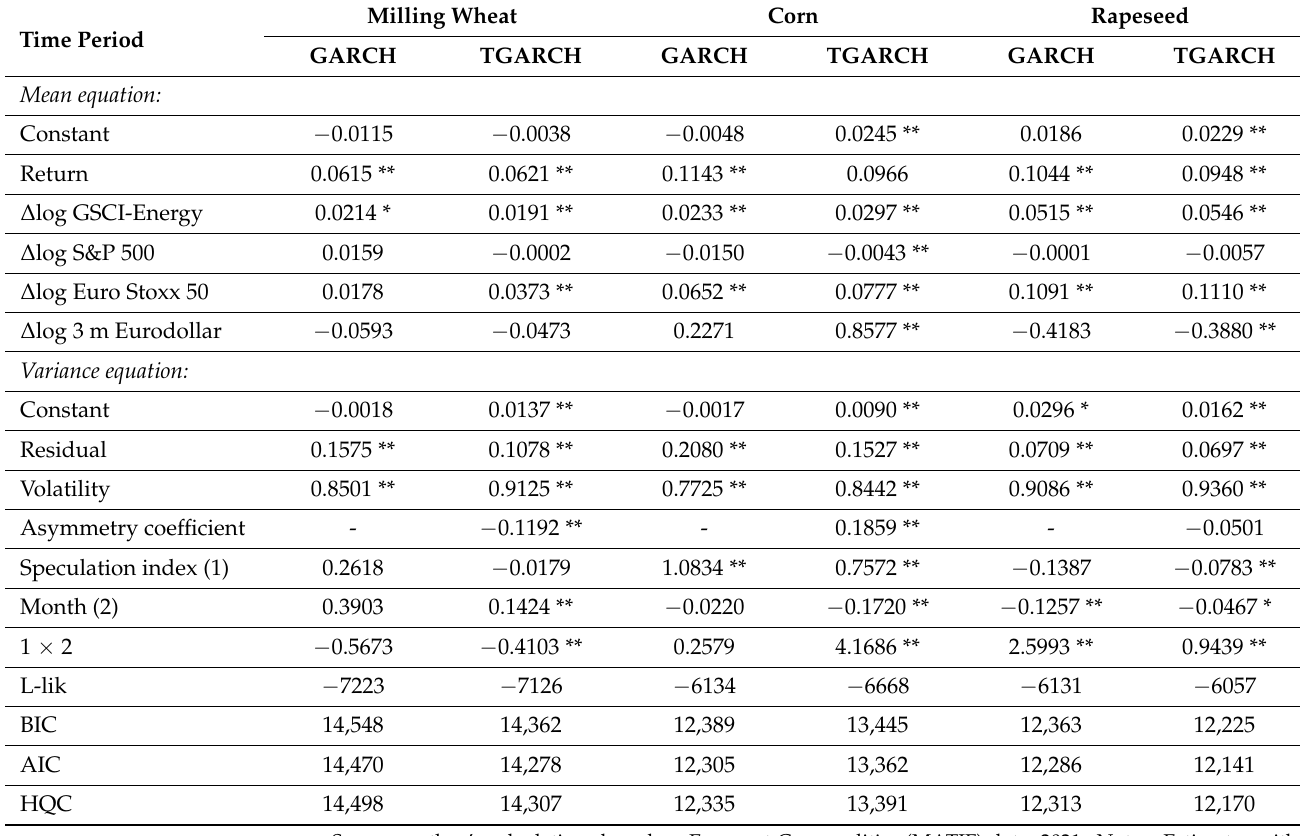
Table A2. Estimates of GARCH commodity-return models with additional variables using Frame- work II with a month’s